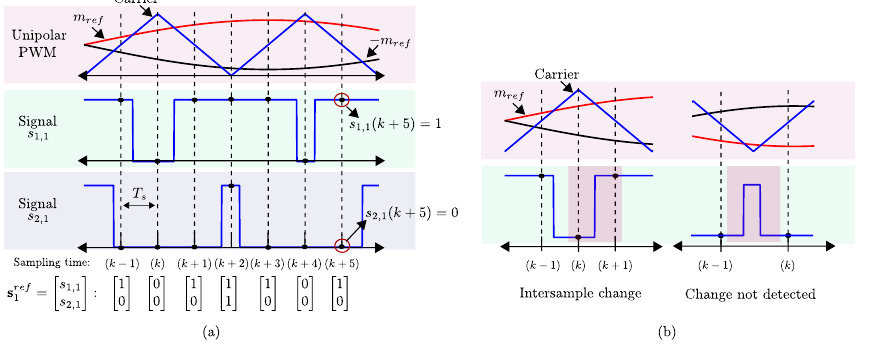
Figure 4. Proposed FCS-MPC applied to grid-connected CHB inverter. Modulation